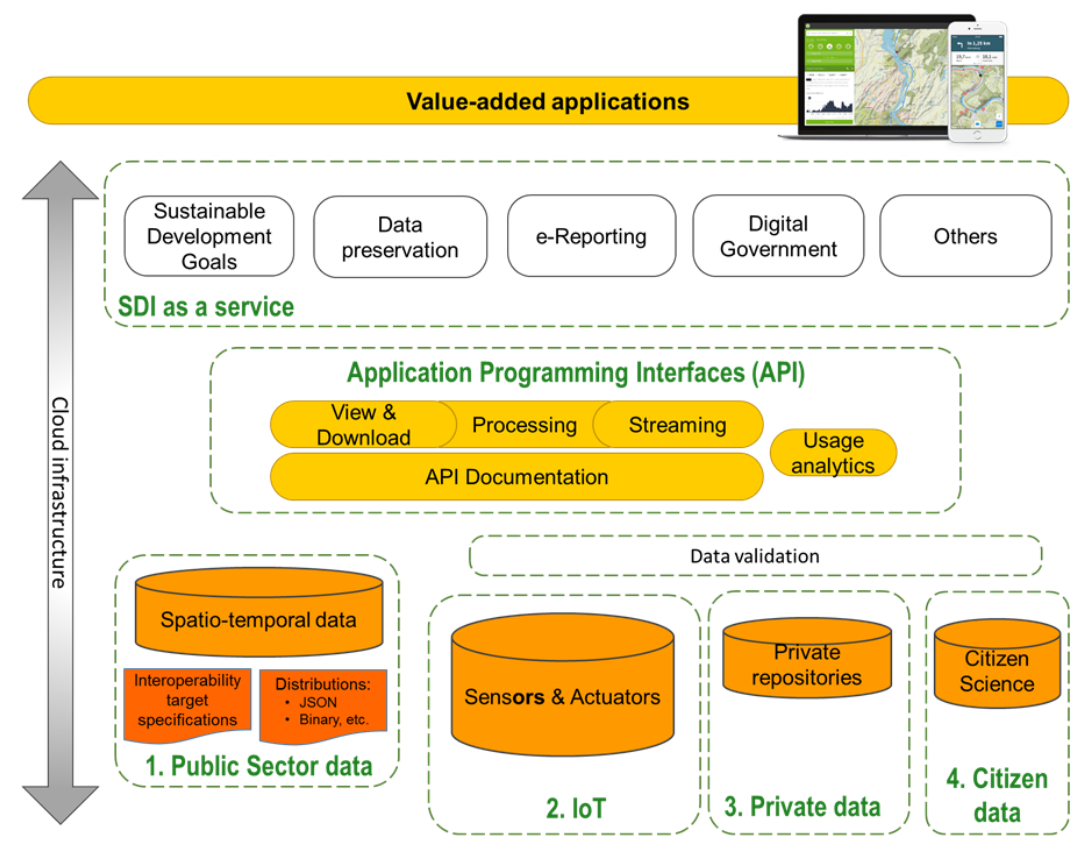
Figure 4. Modernised architecture of a Spatial Data Infrastructure (SDI). Adapted from